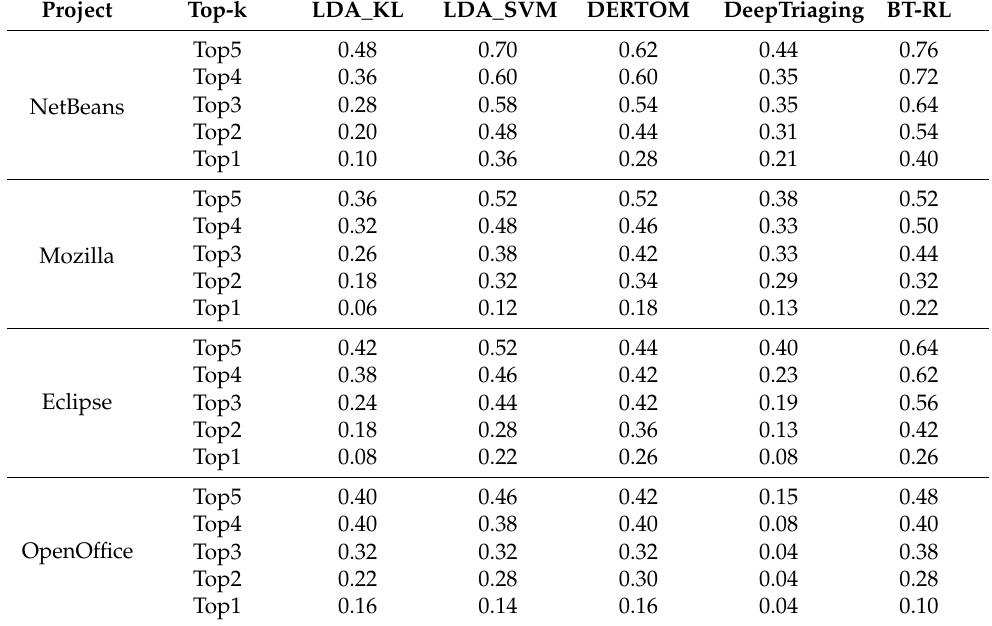
Table 4. The accuracy of BT-RL and other benchmarks on four projects of the second experimental window.